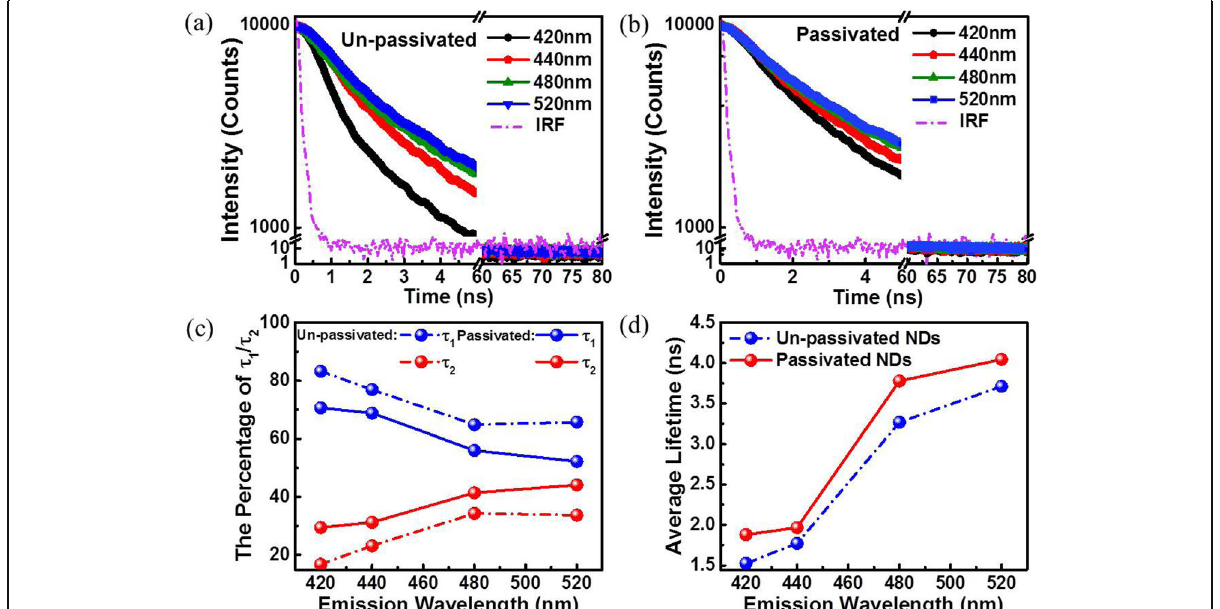
Fig. 6 Time-resolved luminescence of un-passivated ( a ) and passivated ( b ) NDs at different luminescence wavelengths. ( c ) Percentage of τ 1 and τ 2 changes at different luminescence wavelengths. ( d ) Average lifetime of different luminescence wavelength for passivated and un-passivated